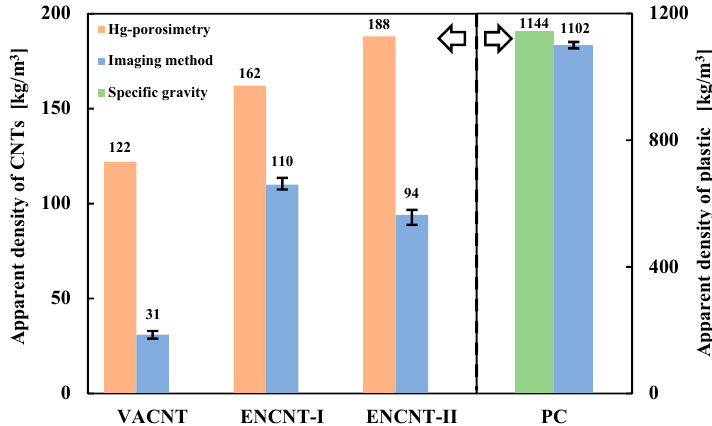
Figure 7. The apparent particle densities by imaging, Hg-porosimety and pycnometer methods.